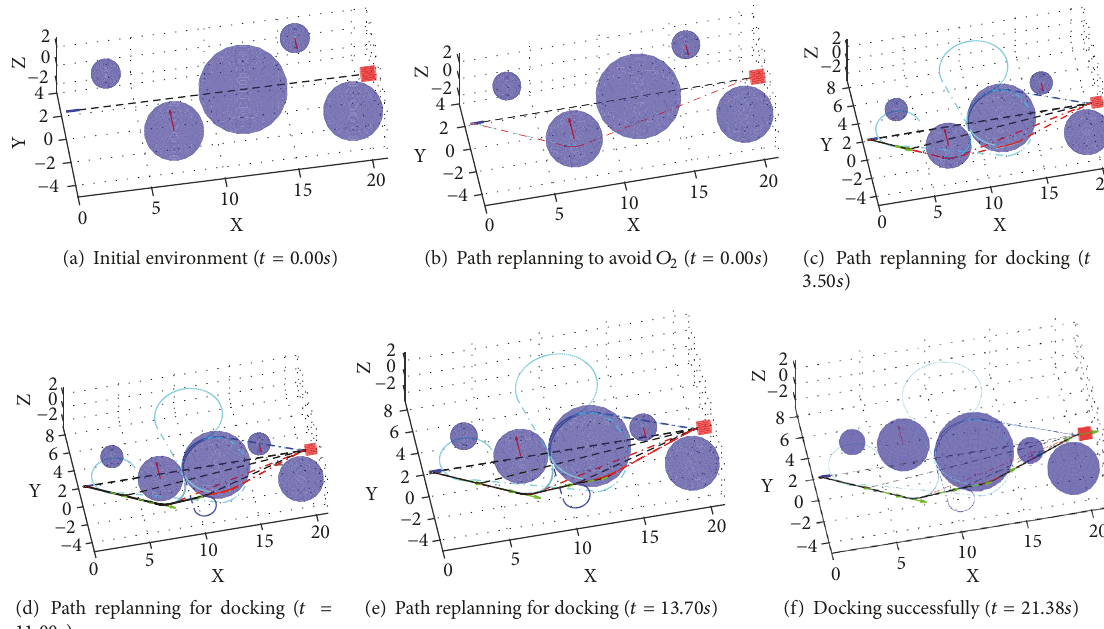
Figure 6: Simulation results of the smooth path planning approach in unknown environment with both static and moving obstacles.